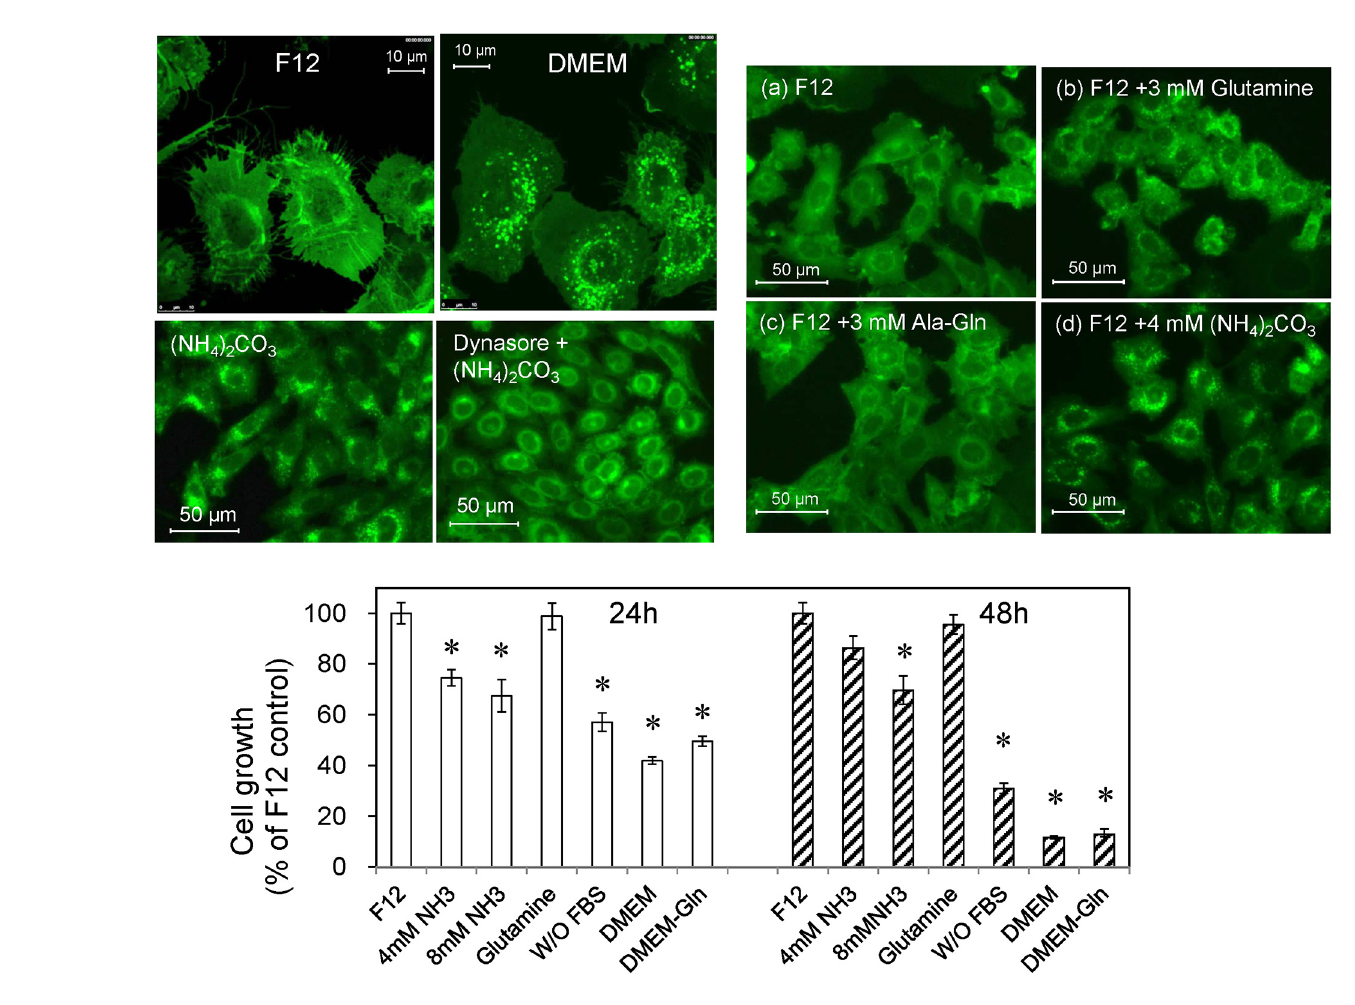
Fig 2. L-Glutamine and ammonia induce fluorescent puncta in GFP-MARCO-CHO cells. (A) The cells were cultured in either F12 complete medium or DMEM complete medium and the fluorescence images were captured by confocal microscopy. Many puncta (200 – 600 nm in diameter) appeared when the cells were culture in DMEM. (B) The cells were cultured for 12 hr in (a) F12 complete medium (containing 1 mM L-glutamine), (b) F12 medium supplemented with 3 mM L-glutamine (to a final concentration of 4 mM L-glutamine), (c) F12 medium supplemented with 3 mM L-alanyl-L-glutamine (Ala-Gln), or (d) F12 medium supplemented with 4 mM (NH 4 ) 2 CO 3 . (C) Proliferation of GFP-MARCO-CHO cells in different culture media. The cells were suspended in F12 medium at 2.0 x 10 4 cells /mL, aliquotted at 100 μ L/well in a 96-well culture dish, and pre-cultured overnight. The medium then was replaced with fresh medium as follows: F12 medium; F12 medium supplemented with 4 or 8 mM (NH 4 ) 2 CO 3 ; F12 containing 4 mM L-glutamine, F12 without 10% FBS; DMEM; or L-glutamine-free DMEM. Cells then were cultured for 24 h or 48 h. The viable cells were assayed using WST-8. Data are presented as mean ± SEM of 6 wells per medium per time point. * , Significantly different from control (F12) value. (D) Loss of ammonia-induced fluorescent small puncta upon inhibition of the endocytic pathway. The cells were cultured in F12 culture medium and exposed to 4 mM ammonium carbonate for 6 hr in the absence or presence of 100 μ M dynasore, a dynamin